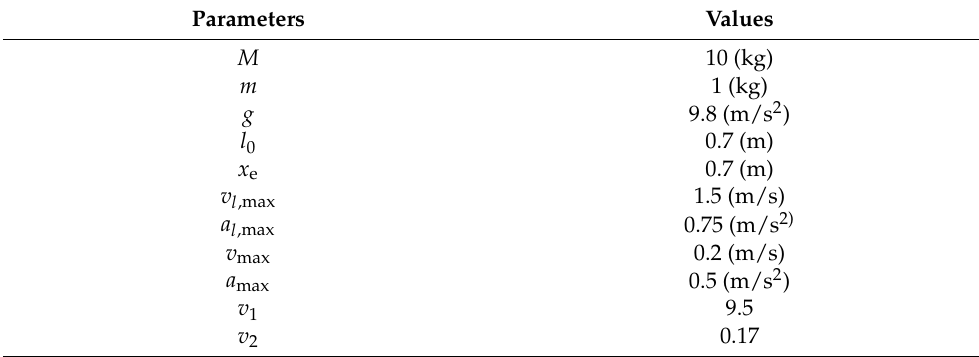
Table 1. Parameters of 2D overhead crane.